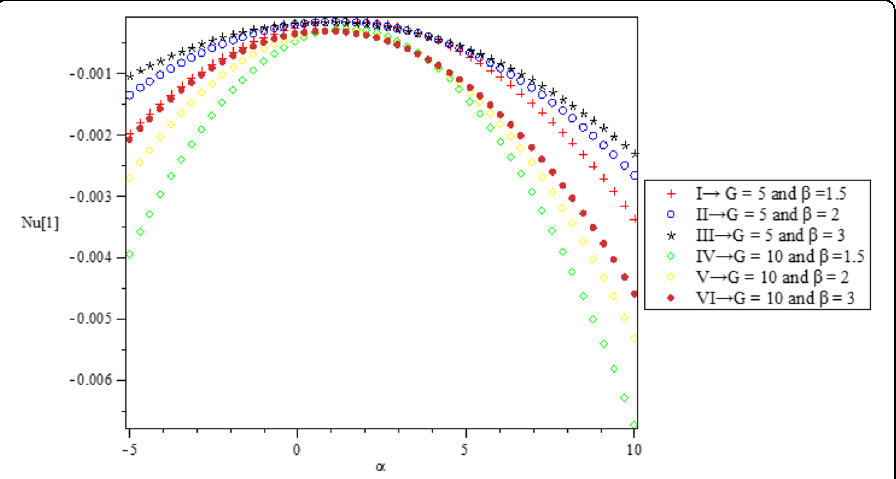
Fig. 32 First-order Nusselt number (Nu[1] profile, r = − 1, ϵ = 0.25, P = 0.71, λ = 0.01, and y =